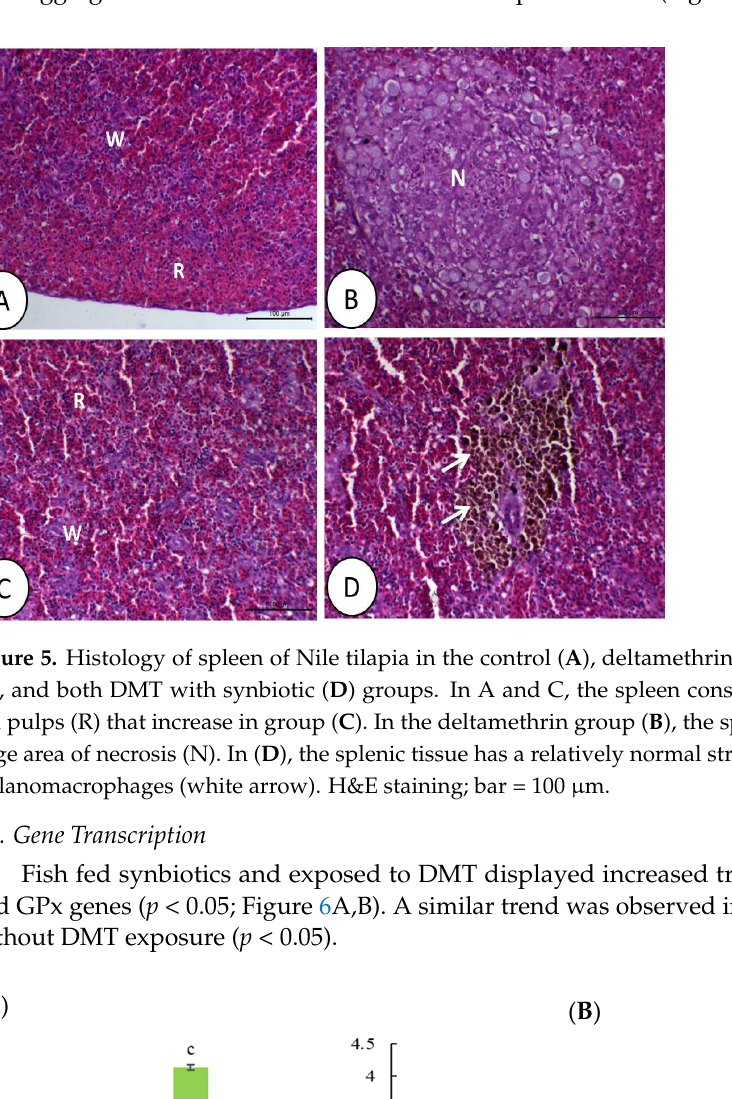
Figure 7. Transcription of ( A ) heat shock protein 70 (HSP70) and ( B ) caspase 3 (CASP3) in Nile tilapia treated with del- tamethrin (DMT) with synbiotic feeding. Bars represent mean ± SD (n = 3), and different letters show significant differences ( p < 0.05). IL-1 β was downregulated in tilapia with DMT exposure and upregulated by synbi- otic and DMT + synbiotic ( p < 0.05; Figure 8A). However, compared to the control, IFN- γ displayed significantly increased transcription when fish were exposed to DMT and fed synbiotic (DMT + synbiotic) ( p < 0.05; Figure 8B). DMT resulted in lower IL-8 transcription than that in the other groups ( p < 0.05; Figure 8C). Fish fed synbiotics and exposed to DMT (DMT + synbiotic) showed more IL-8 upregulation than that in the other groups ( p < 0.05). Notably, fish exposed to DMT without symbiotic feeding showed the lowest expression of IL-8 ( p < 0.05).